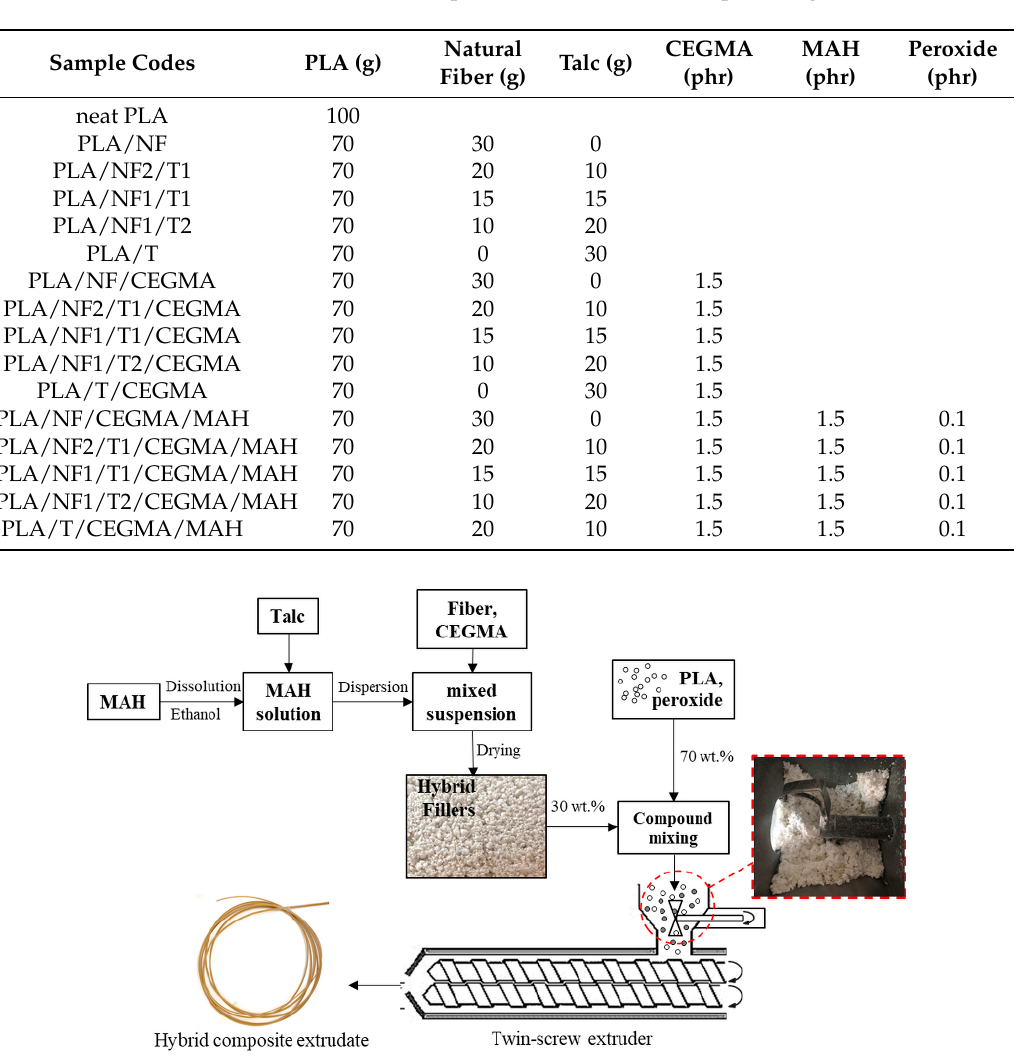
Figure 1. Schematic representation of the simplified preparation of hybrid fillers and extrusion compounding process of the reactive hybrid composites.